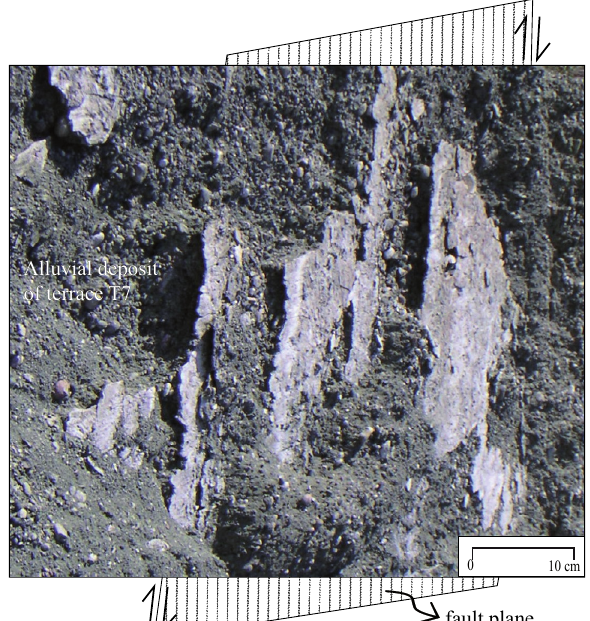
Figure 4 (right). Fault plane of the Burcal Normal Fault through the alluvial deposit of terrace T7 at the middle reaches of the De- voll river. See Figure 1 for the location of the